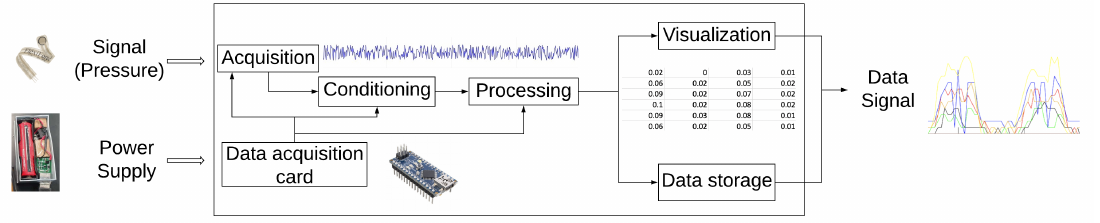
Figure 6. Schematic diagram of the socket interface pressure (SIFP)